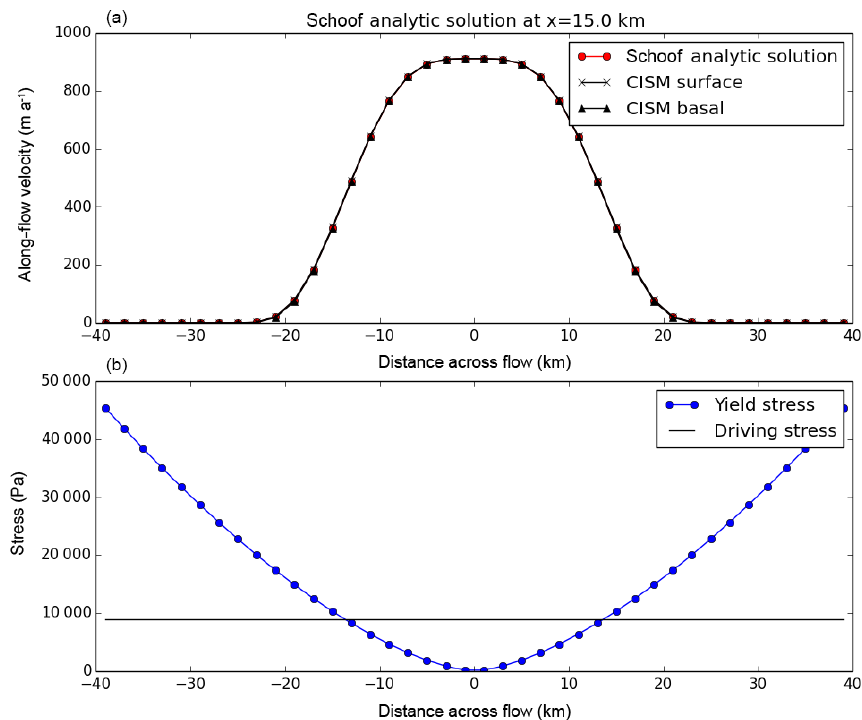
Figure 7. Same as Fig. 6 but for the Schoof stream test with a smooth transition in yield stress. The analytic and simulated solutions are virtually